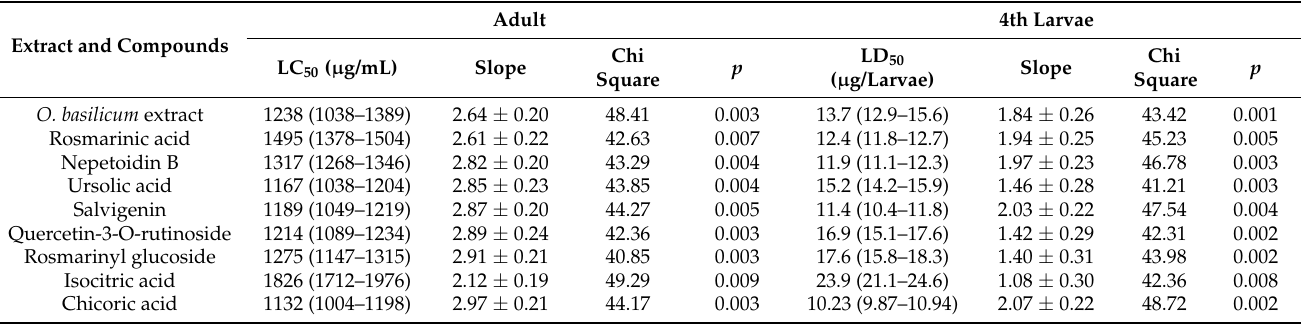
Table 3. Mortality and probit analysis of R. ferrugineus adults and fourth larvae treated with O. basilicum extract and pure compounds.